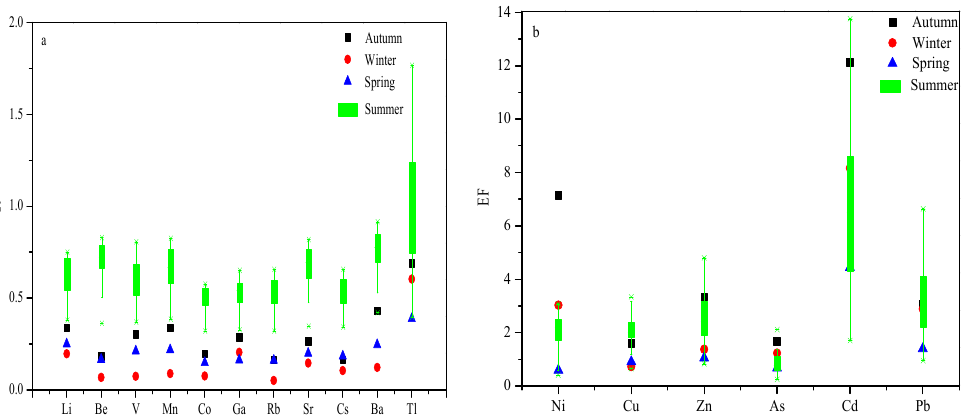
Figure 7. Seasonal enrichment factors of metals in PM 2.5 . ( a ) enrichment factors of Li, Be, V, Mn, Co, Ga, Rb, Sr, Cs, Ba, and T1 ( b ) enrichment factors of Ni, Cu, Zn, Ag, Cd, and Pb. Table 3. The seasonal Al and Fe concentrations and EF values.